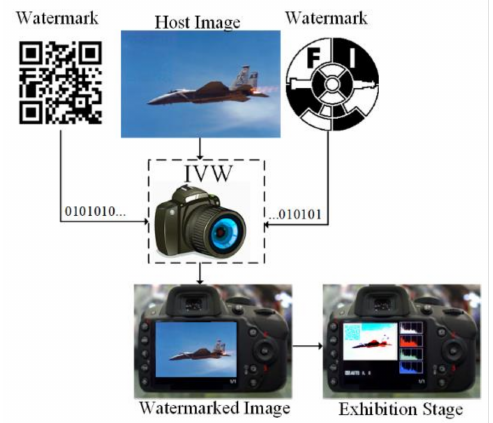
Figure 2. General diagram of the